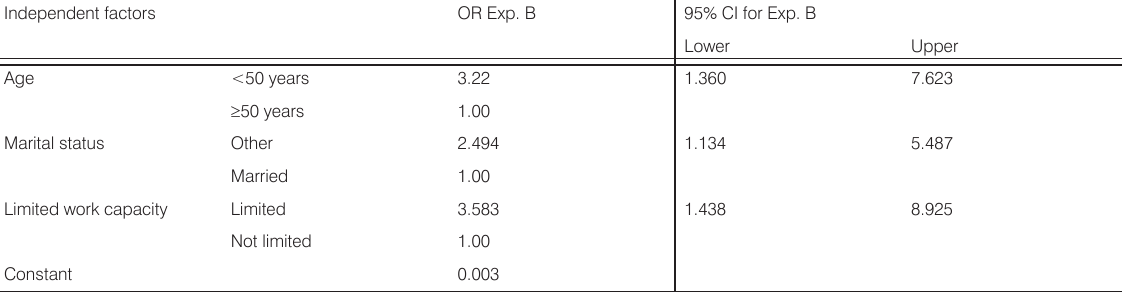
Table 2. Relation between depression and socio-demographic and clinical